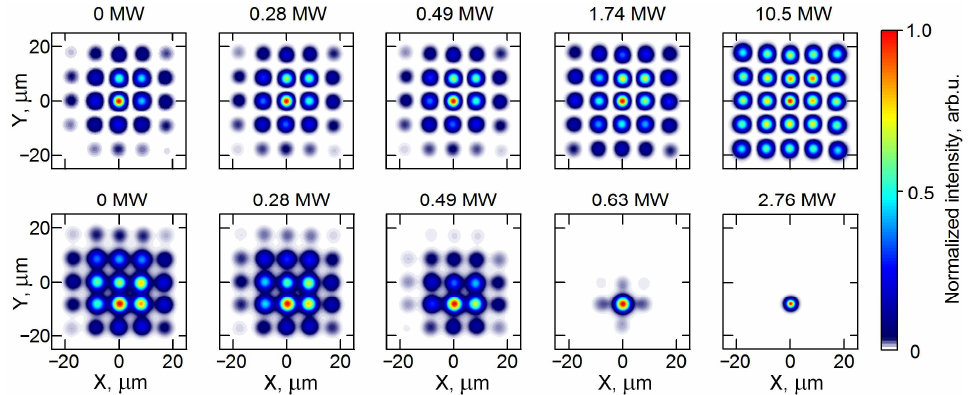
Figure 6. Numerical simulation of the out-of-phase supermode ( upper row ) and the in-phase supermode ( lower row ) propagation at different total power levels.